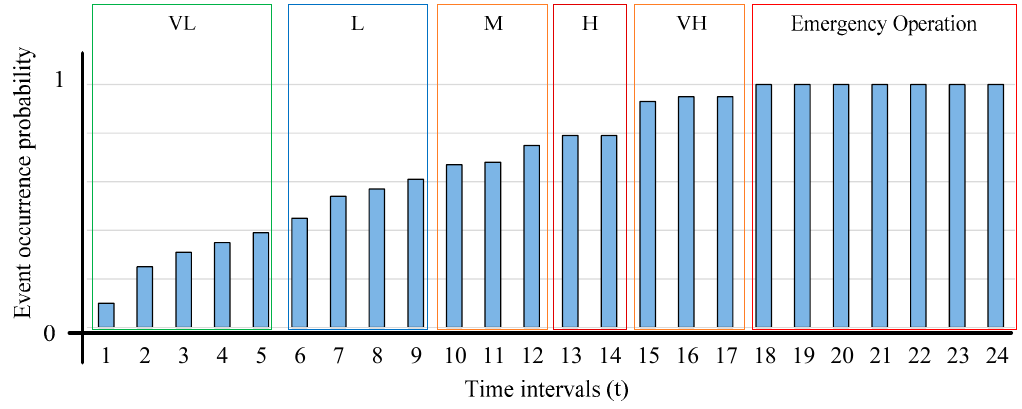
Figure 13. Simulated scenario for evaluating proposed strategy during emergency mode operation.